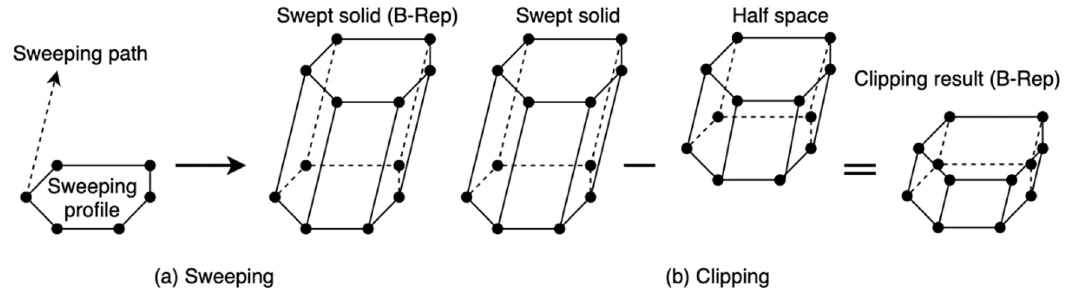
Figure 12. Converting Sweeping and Clipping to